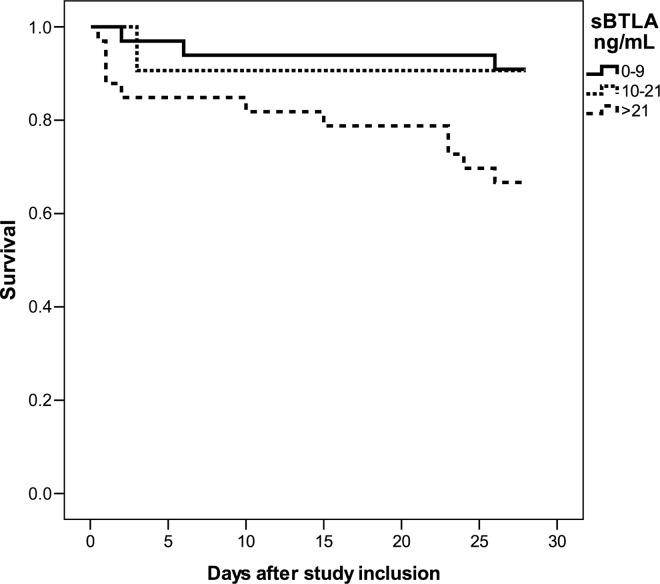
Survival curves for patients in the sepsis cohort at different baseline sBTLA concentrations.Survival curves based on the 33rd and 67th percentile of baseline sBTLA concentration day 0–28 after study inclusion.